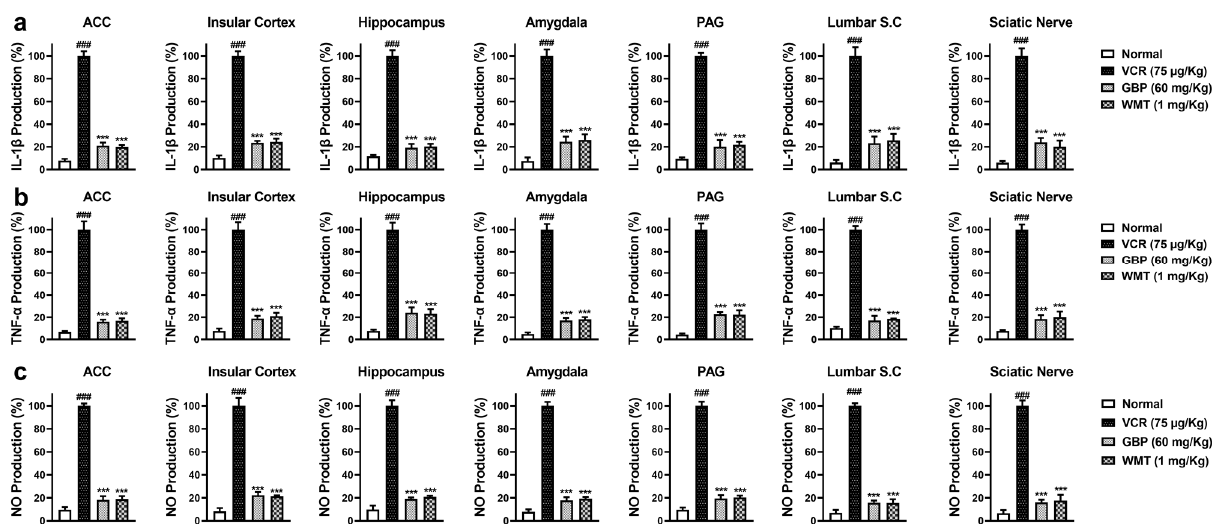
Figure 5. The effect of withametelin on the levels of the cytokines and NO production in the different regions of the brain, spinal cord, and sciatic nerve of the VCR model. IL-1β ( a ), TNF-α ( b ), and NO production ( c ). The results were expressed in percentages. All results were expressed as the mean ( n = 5) ± SD. The experiment was performed in triplicate independently. ### p < 0.001 compared to the normal control group; *** p < 0.001 compared to the VCR group.